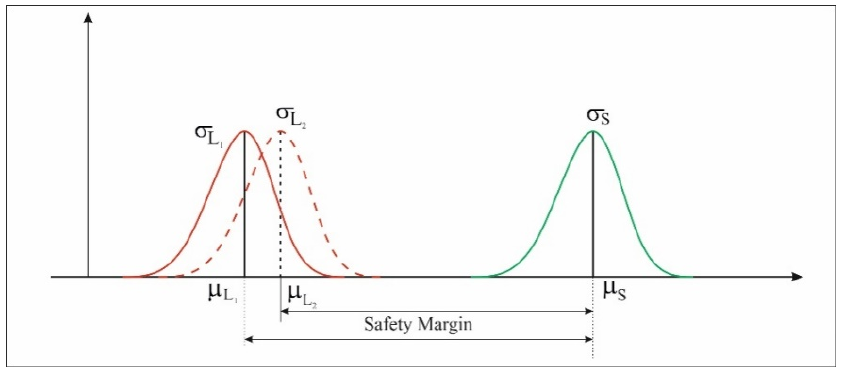
Figure 10. Load and Strength relationship.